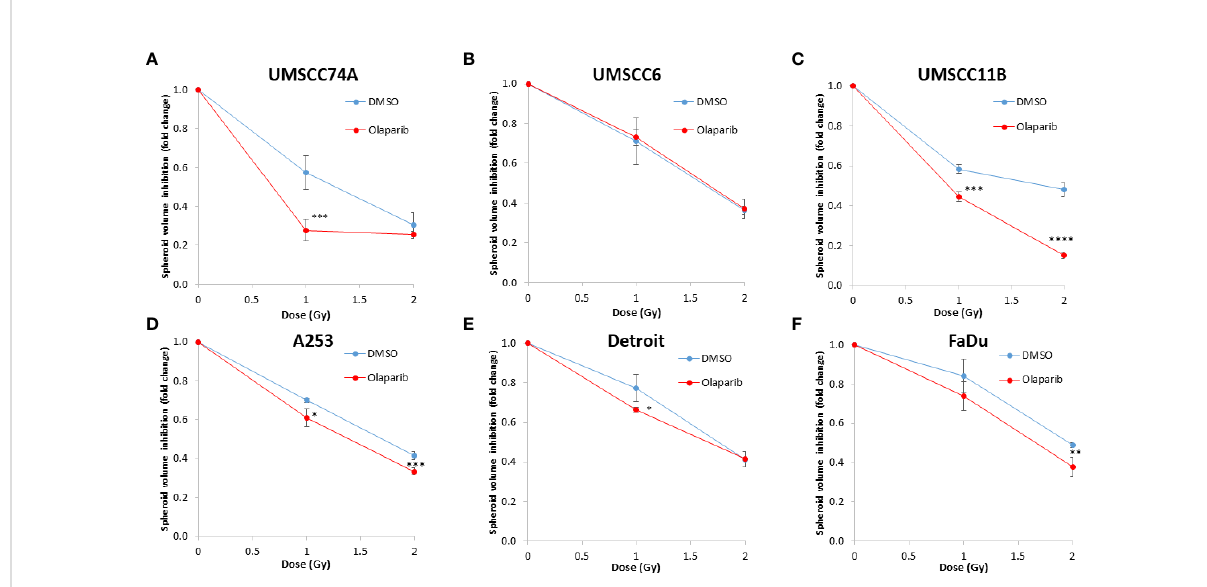
FIGURE 3 Impact of olaparib on the enhancement of the radiosensitivity of HPV-negative HNSCC spheroids. (A – F) The fold growth of HPV-negative HNSCC spheroids from days 3 to 12 post-seeding was determined relative to the x-ray radiation dose, and this was normalised to the unirradiated control which was set to 1.0. *p < 0.05, **p < 0.02, ***p < 0.01, ****p < 0.001 as analysed by a two-sample t-test.